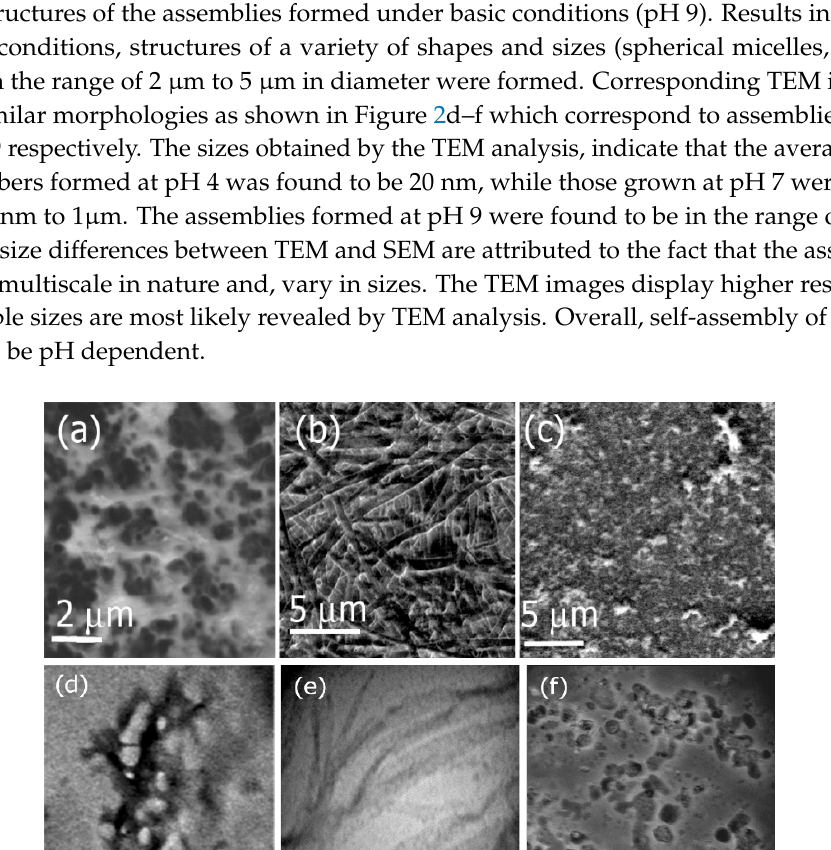
Figure 2. SEM images of Ile-TMG-Ile assemblies formed at ( a ) pH 4; ( b ) pH 7 and at ( c ) pH 9. TEM images of the assemblies are shown at ( d ) pH 4 (scale bar = 500 nm; ( e ) pH 7 (scale bar = 2 μ m) and ( f ) pH 9 (scale bar = 1 μ m nm).